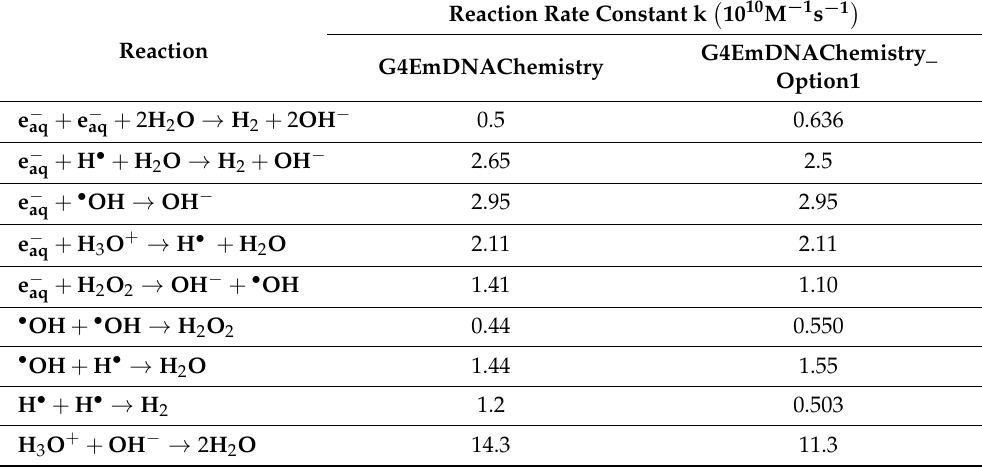
Table 3. Implemented chemical reactions and reaction rate constants k [82,83] as defined in the two chemistry constructors “G4EmDNAChemistry” and “G4EmDNAChemistry_option1” that apply at ambient temperature (25 ◦ C) of Geant4-DNA version